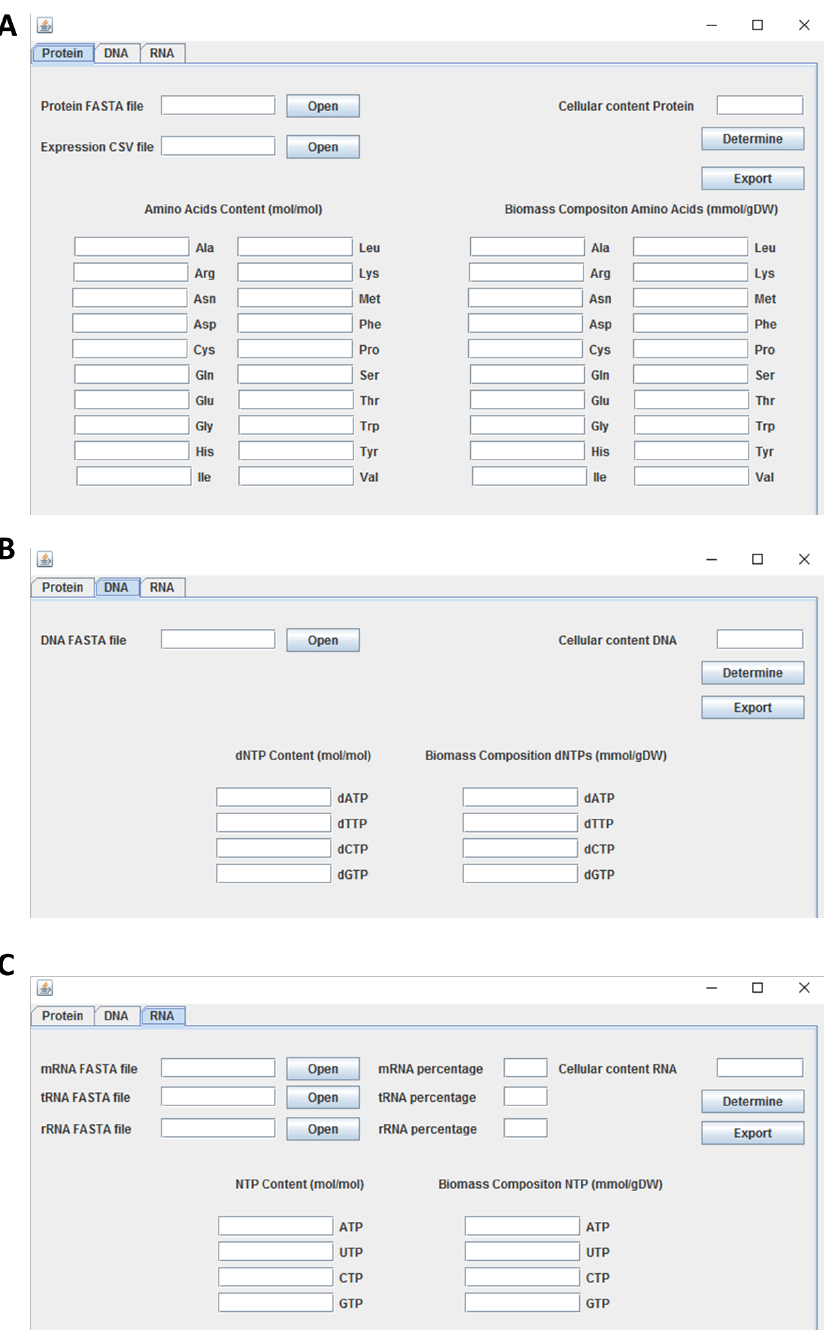
Figure 2: Screen-shots from the java application developed. Tabs to estimate and provide results for (A) Protein composition in each amino acid, (B) DNA composition in each dNTP, and (C) RNA composition in each